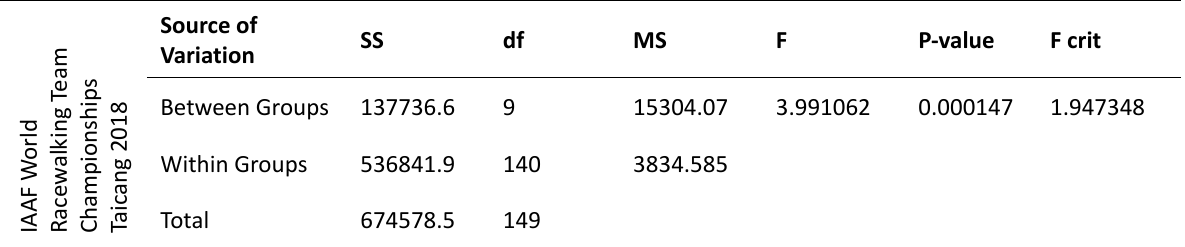
Table 9. Analysis of variance (ANOVA: Single Factor) between performance time averages of the race stages in WRTC2018